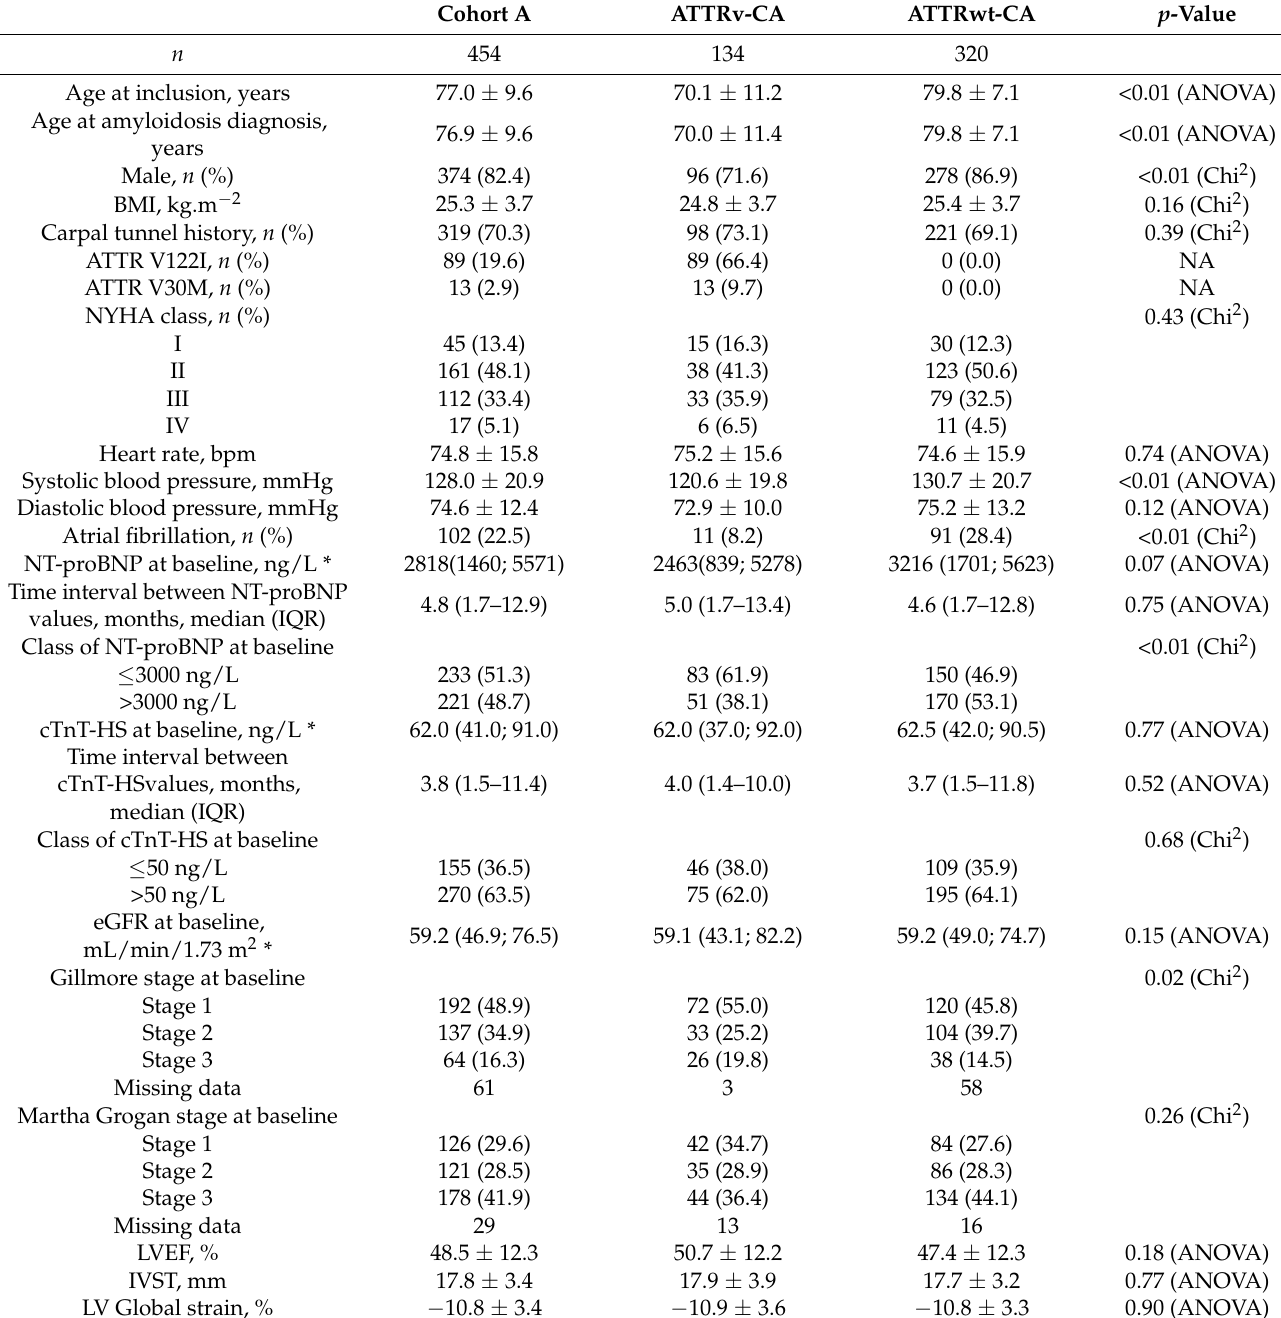
Table 1. Characteristics of patients (Cohort A), according to genotype, assessed for the impact of NT-proBNP levels on event-free survival ( n =